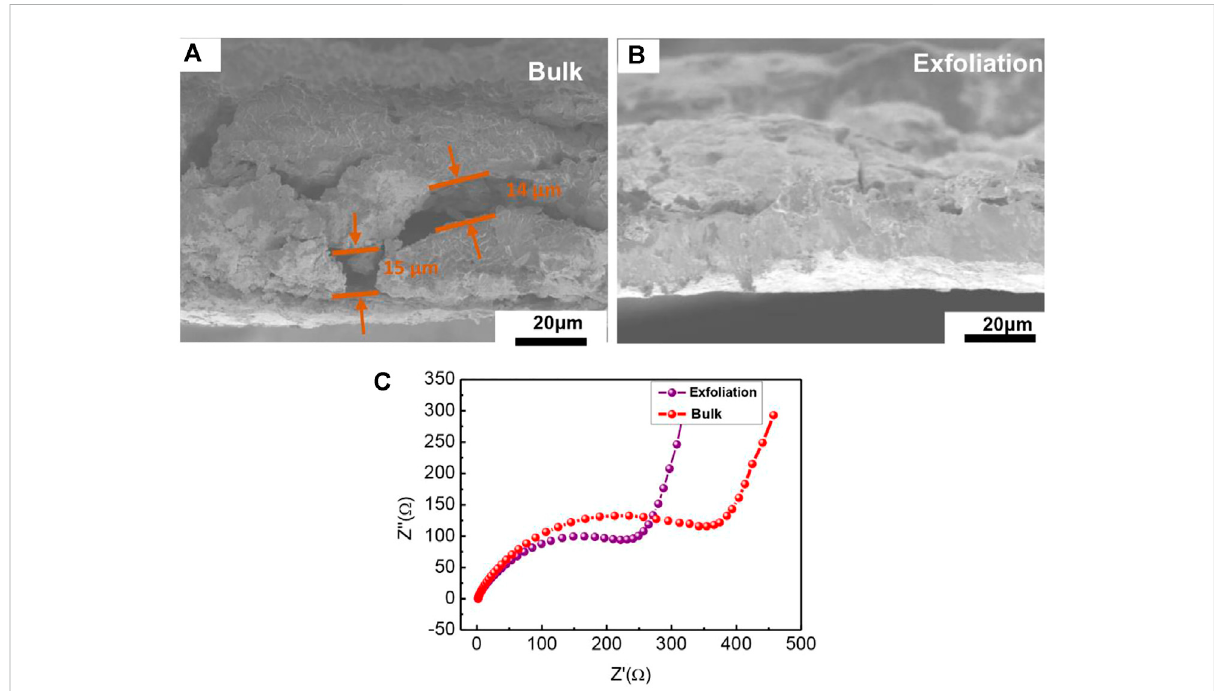
FIGURE 4 The performance analysis of MnPSe 3 electrode. (A,B) The side SEM of MnPSe 3 electrode before and after exfoliation in 100 charge/discharge cycles. (C) The impedance of MnPSe 3 electrode in 100 charge/discharge cycles before and after exfoliation, respectively.